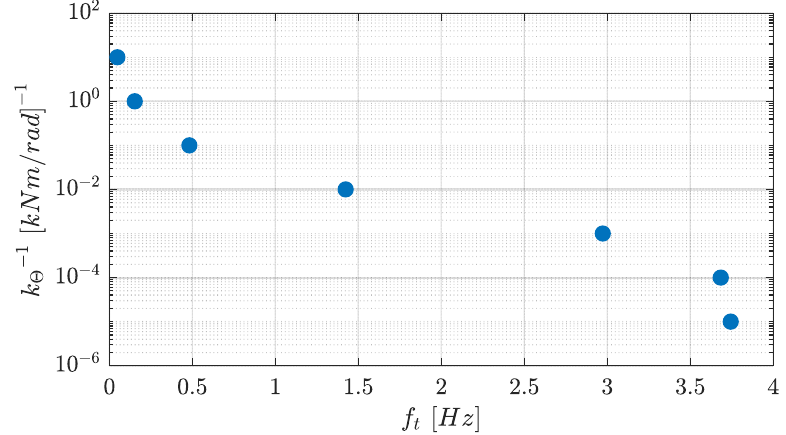
Figure 3. Influence of the rotational flexibility (1/ k θ ) on the estimation of the translational frequency f t .